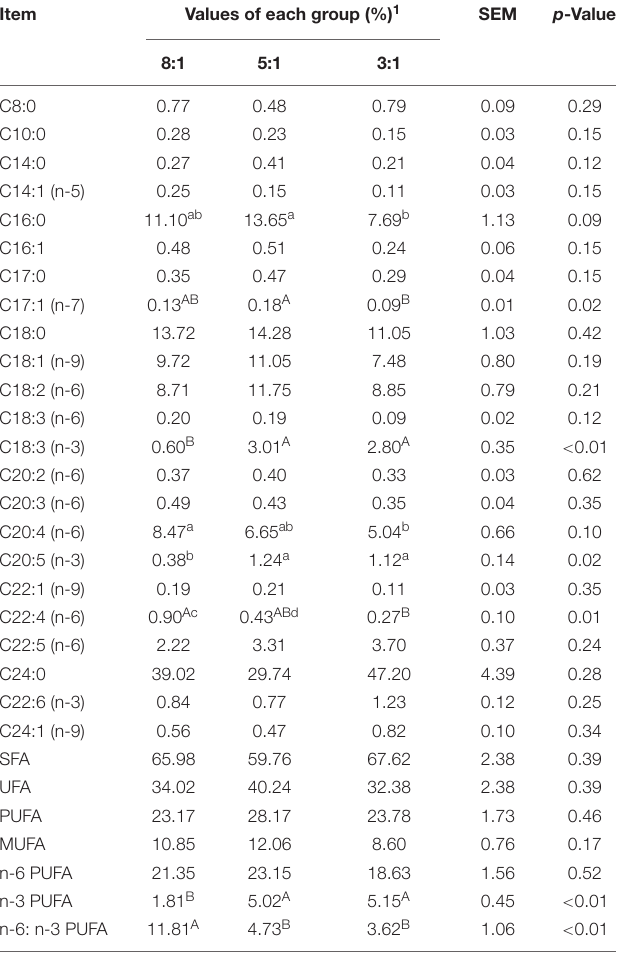
TABLE 1 | Medium- and long-chain fatty acid profiles in serum of Heigai pigs fed with different diets.